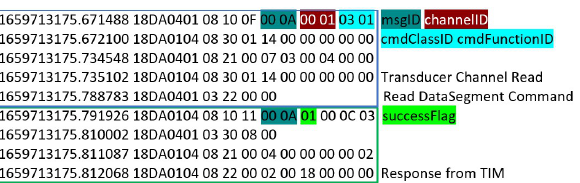
Figure A2. CAN Messages for Transducer Channel DataSegment